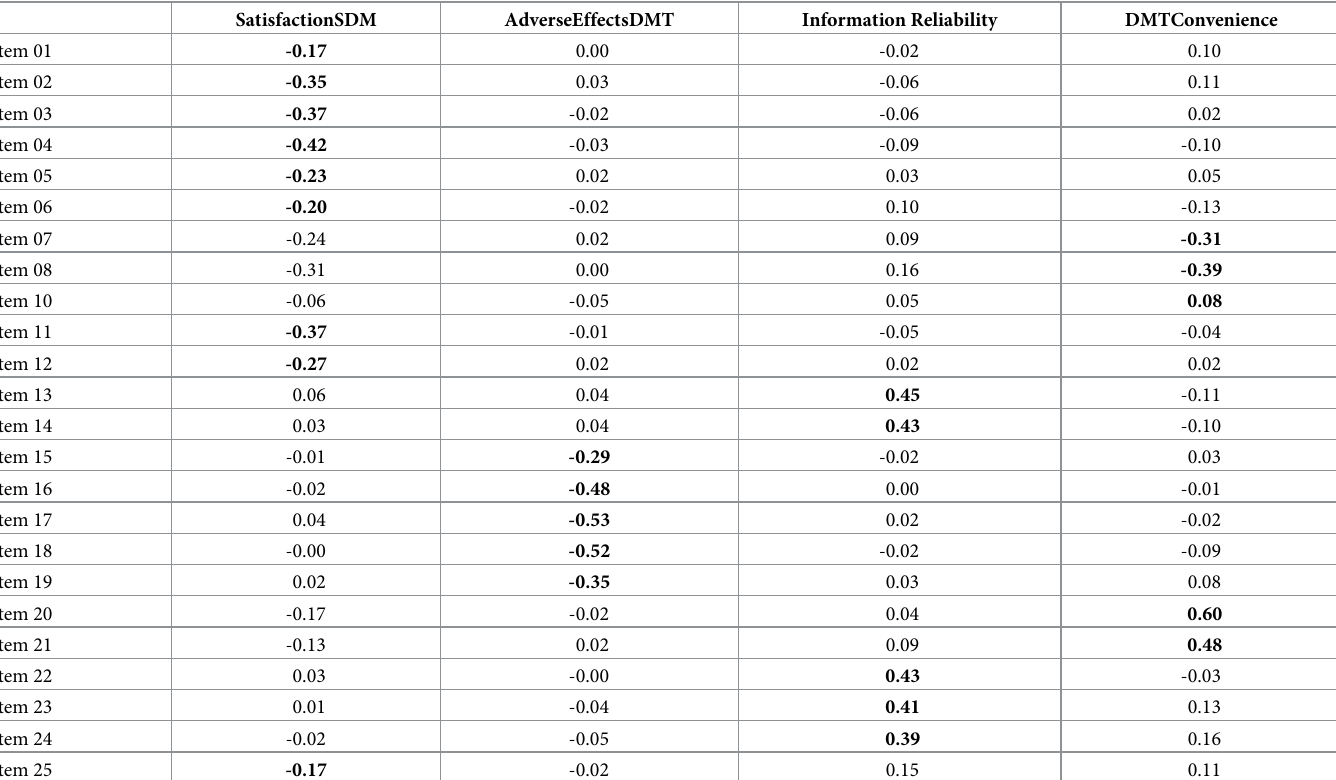
Table 4. Factorial